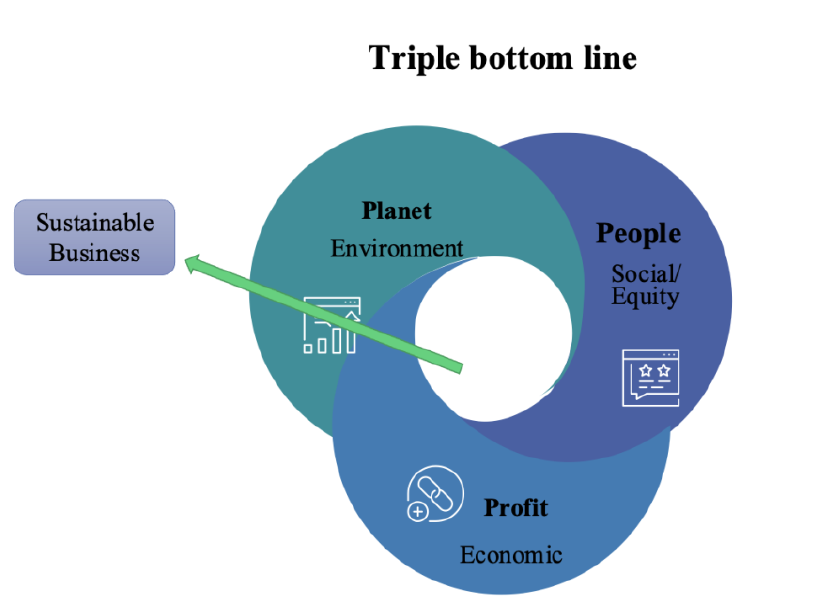
Figure 1: Triple bottom line; Source: M. Sarfraz et al.